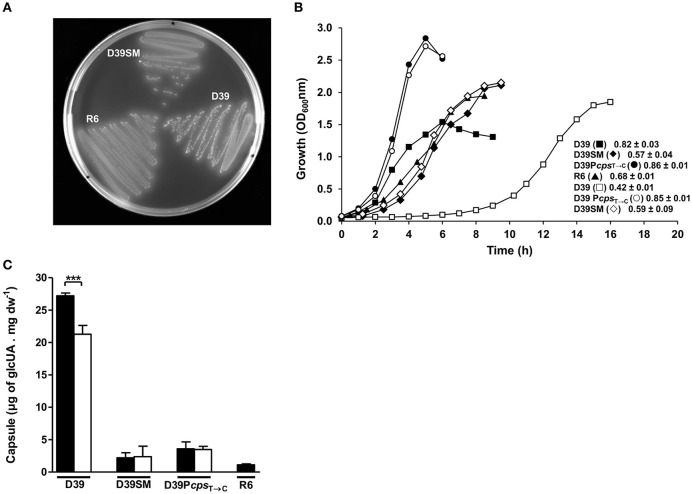
Colony phenotype, growth profile, and capsule production in D39 and its derivatives. (A) Colony phenotype of D39, D39SM, and R6 strains in Glc-M17 blood agar plates. (B) Growth profiles of strains D39 (squares), D39SM (diamonds), D39PcpsT→C (circles) and R6 (triangles) in Glc-CDM (closed symbols) and Glc-CDM without uracil (open symbols), at 37°C, without pH control (initial pH 6.5), in static rubber-stoppered bottles. The growth rates (h−1) for each strain are indicated in the graph and the values shown are means from three biological replicates ± SD. (C) Estimation of capsule was performed based on the determination of its glucuronic acid content in D39 and its derivatives grown in Glc-CDM (black bars) and Glc-CDM lacking uracil (white bars), at mid-exponential phases of growth. Capsule measurements were performed in duplicate using samples from two independent cultures and the values represented are means ± SD. ***p-value = 0.0002.